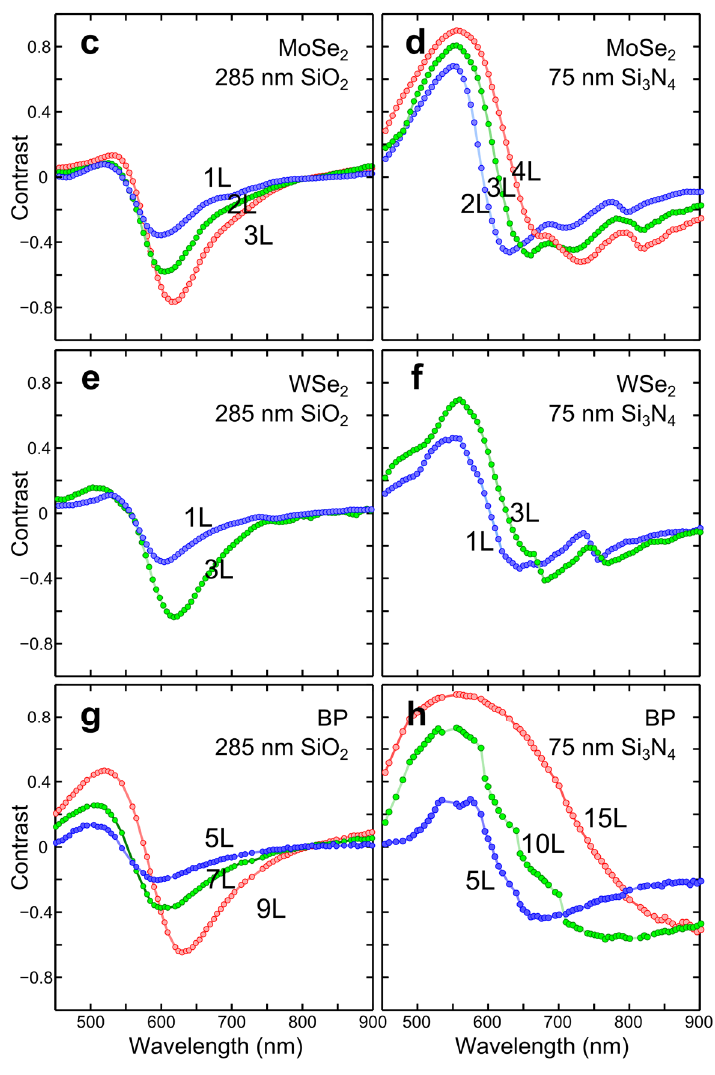
Figure 4. Wavelength dependence of the optical contrast measured for MoS 2 , MoSe 2 , WSe 2 and black phosphorus flakes of different thickness. ( a , b ) optical contrast of MoS 2 on 285 nm SiO 2 /Si and 75 nm Si 3 N 4 /Si, respectively; ( c , d ) optical contrast of MoSe 2 on 285 nm SiO 2 /Si and 75 nm Si 3 N 4 /Si, respectively; ( e , f ) optical contrast of WSe 2 on 285 nm SiO 2 /Si and 75 nm Si 3 N 4 /Si, respectively; ( g , h ) optical contrast of black phosphorus on 285 nm SiO 2 /Si and 75 nm Si 3 N 4 /Si,